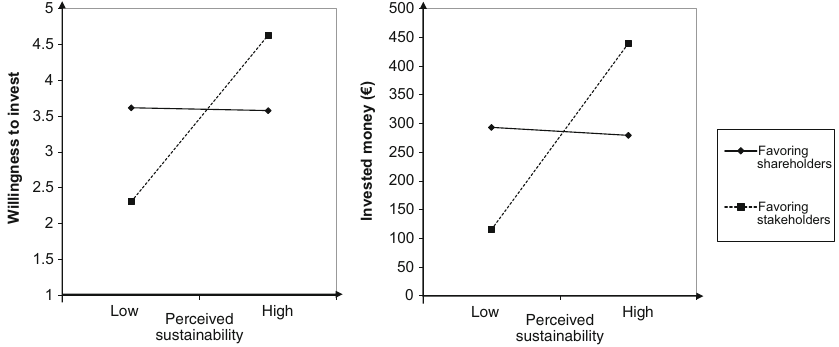
Fig. 1 Interaction effect of stakeholder management and assumed costs on participants’ willingness to invest and amount of money invested